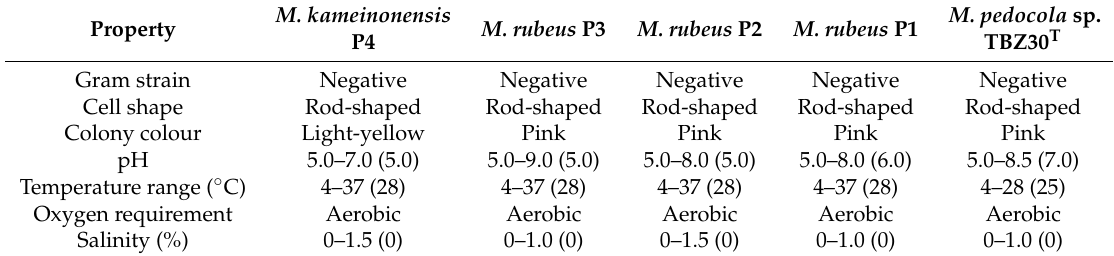
Table 3. General features of strains M. rubeus P1, P2, and P3 and M. kameinonensis